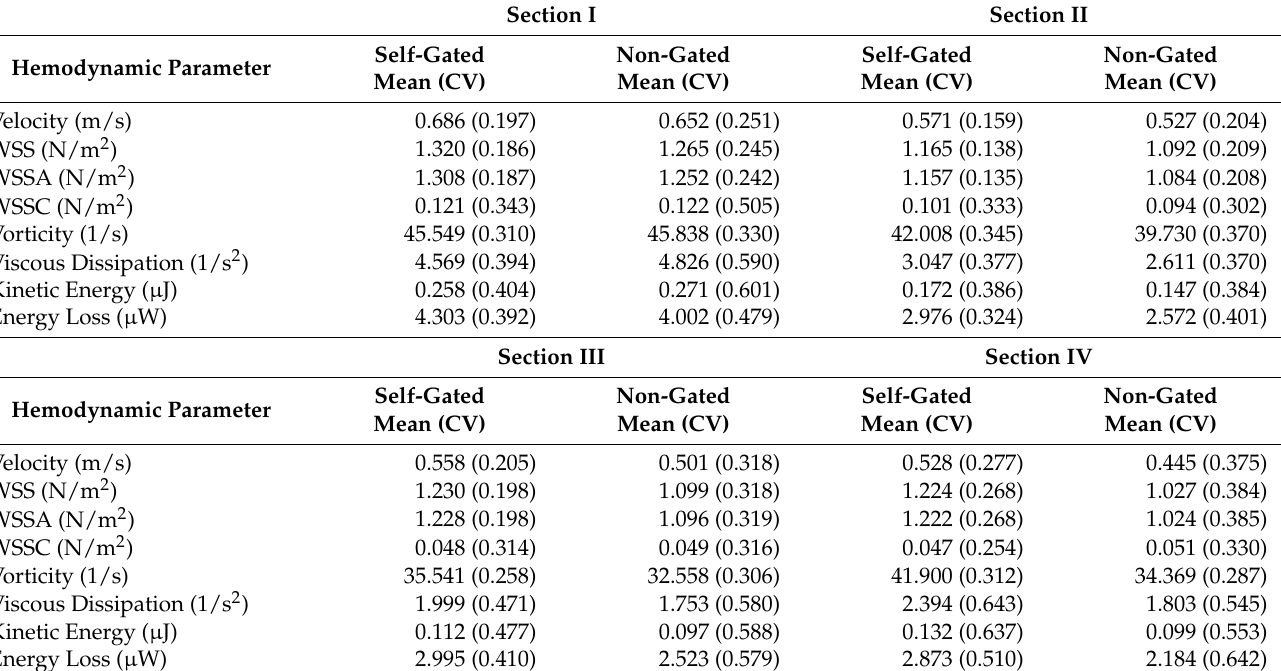
Figure 1. The hemodynamic parameters obtained from 4D flow MRI, both with and without self- gating. In this figure, we show visual representations of the hemodynamic parameters for one volunteer, which were measured at a representative peak systolic cardiac phase. Table 2. The hemodynamic parameter means and the coefficient of variation (CV) of the mean values at each section of the vessel for the self-gated and non-gated data, which were measured at a representative peak systolic cardiac